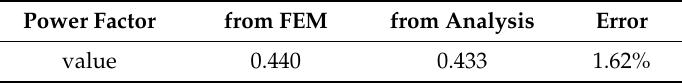
Table 3. Power factor based on different methods.